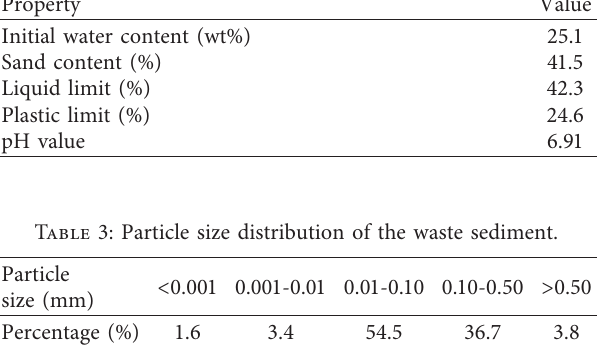
Table 4: Mix proportions of the waste sediment-based grouting material